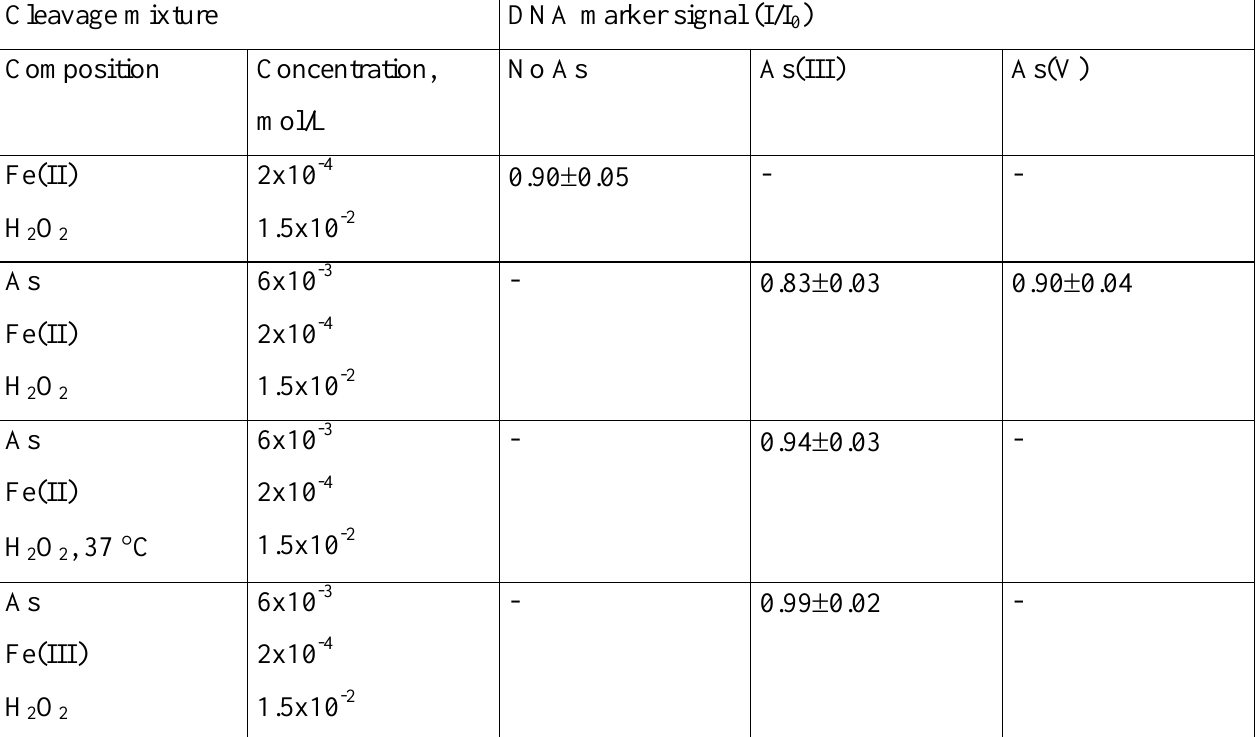
Table 1. Effect of inorganic arsenic on DNA at 10 min incubation of DNA/SPE sensor in cleavage mixtures with Fe(II) ions at 22 ° C (not indicated) and 37 ° C. Conditions: 1x10 -2 mol/L phosphate buffer solution pH 7.0 under